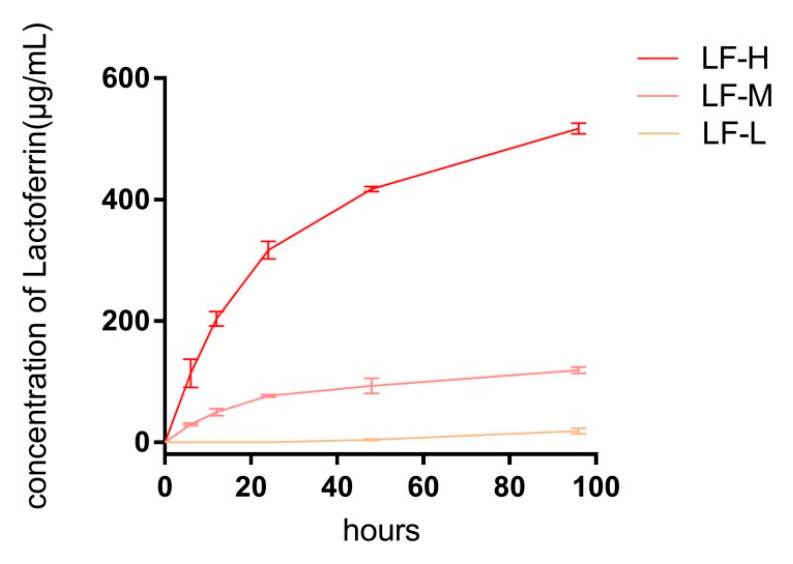
Figure 3. Release kinetics of lactoferrin (LF) on Ti specimens (LF-L, LF-M, and LF-H) in phosphate buffer saline (PBS).